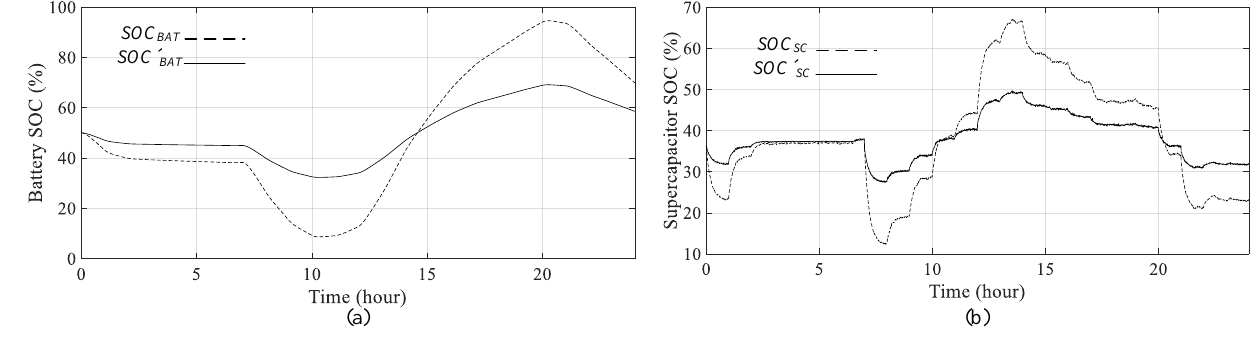
Figure 8. Improved performance of the NG thanks to the RBES acting as EMS. ( a ) SOC BAT and SOC ´ BAT and ( b ) SOC SC and SOC ´ SC .